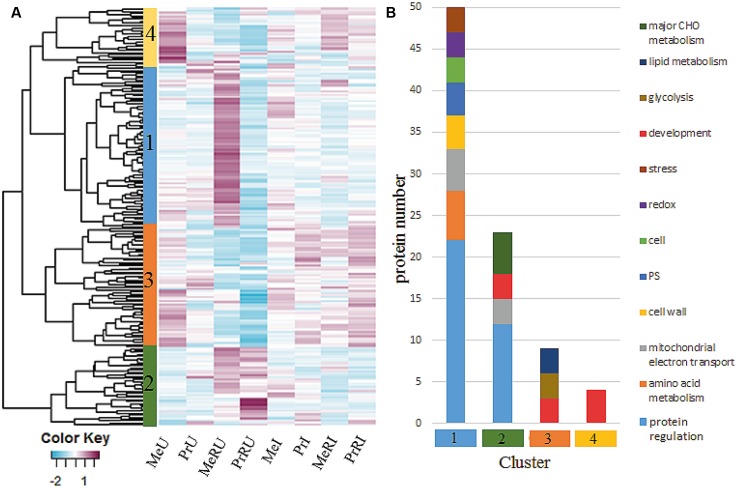
(A) Heatmap of 213 protein intensities from seed extractions which illustrated a significant difference among Rhizobium treatments of healthy and pathogen infected plants. Each cell indicates the z-transformed average protein intensities (n = 3). For cluster analysis, complete linkage and euclidean distance methods were applied; (B) clusters from (A) were functionally grouped by using functional bins from the MapMan Mercator tool. Categories were plotted when comprising >2 proteins.